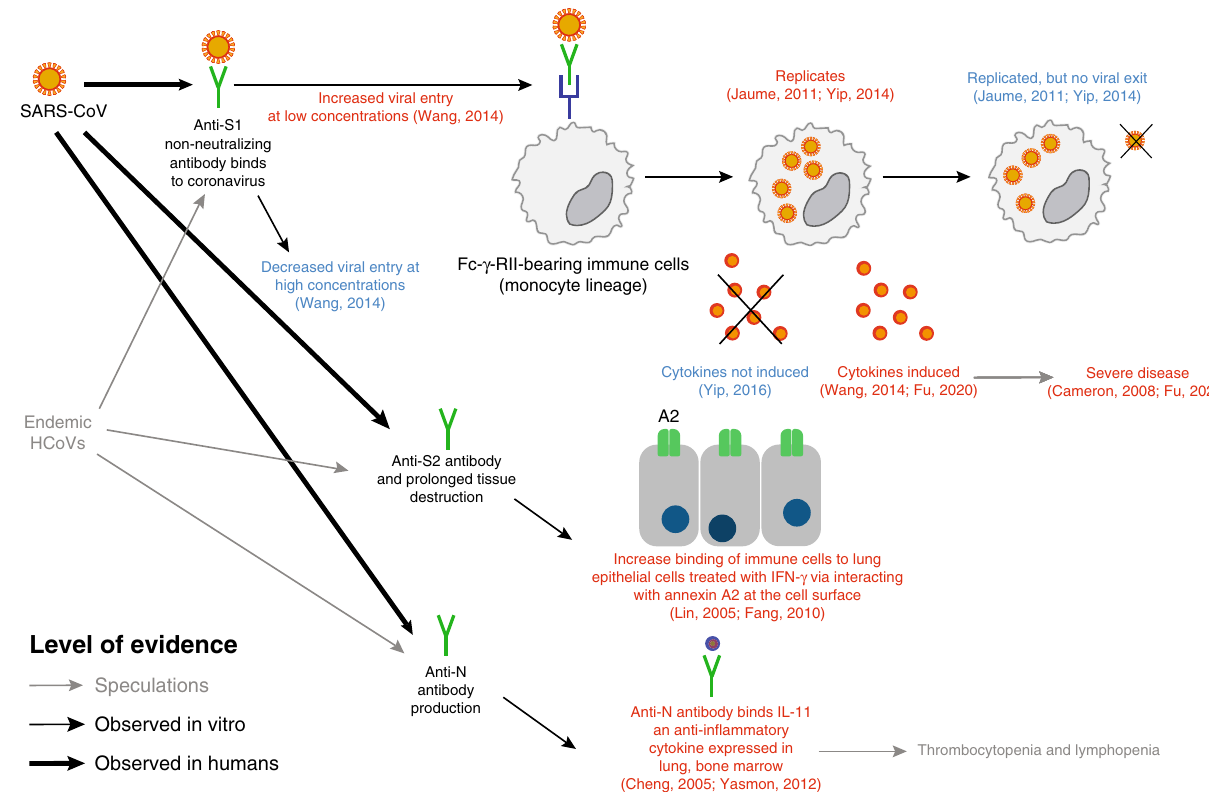
Fig. 5 Evidence supporting/contradicting SARS-CoV antibody-related pathogenesis. Supporting evidence given in red and contradicting evidence in blue. Weaker evidence (speculation in discussions) shown in gray, evidence from in vitro studies in thin lines, and evidence observed in humans in thick lines. Anti-S1 antibodies triggered upon infection may facilitate entry into immune cells at later stages of the infection if concentration is low. Replication happens but no virus is released. Consequential induction of cytokines is inconclusive, but if they occur, they are associated with severe disease. Roles of anti-S2 and anti-N antibodies are supported by binding